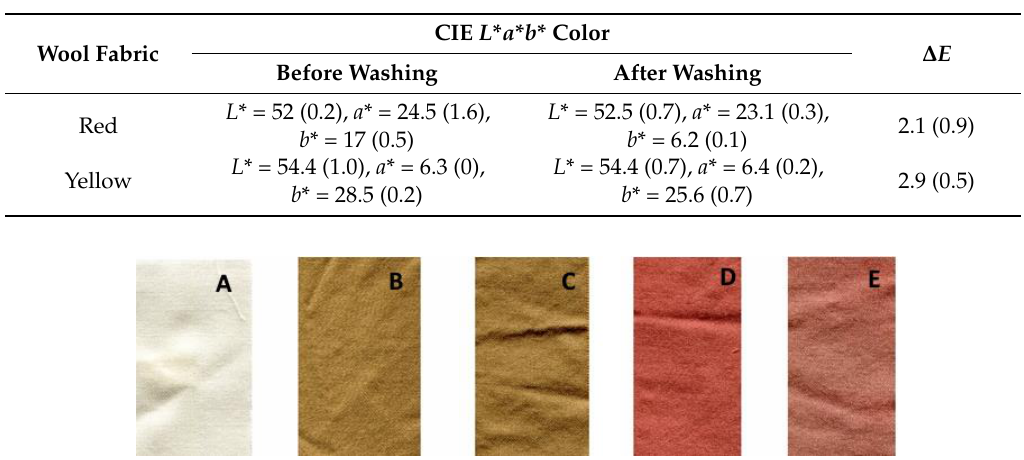
Table 3. Color readings and color difference of dyed samples before and after wet washing.